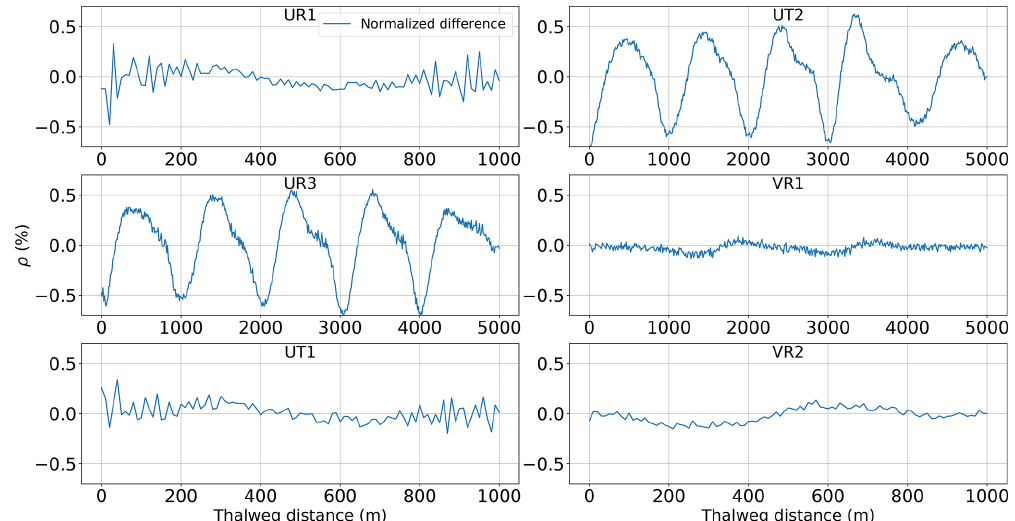
Figure 13. Spatial distribution of normalized difference ( ρ ) for analytical test cases of MacDonald et al.